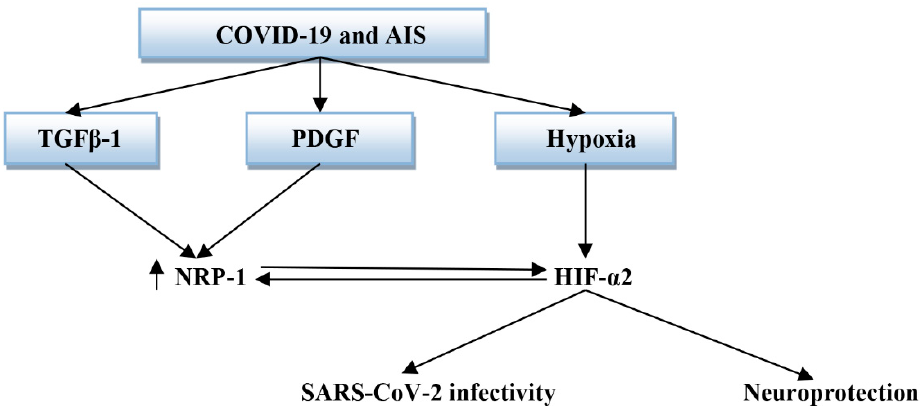
Figure 13. The potential role of the hypoxia-inducing factor (HIF), platelet-derived growth factor (PDGF), and transforming growth factor beta (TGF- β ) in COVID-19 and acute ischemic stroke (AIS): PDGF and TGF- β activate the expression of neuropilin-1 (NRP-1), while hypoxia induces the expression of HIF, which has neuroprotective effect and reduces SARS-CoV-2 infectivity. The net effect of NRP-1 in COVID-19 with AIS is through the induction of anti-inflammatory and antioxidant effects which reduce the severity of both COVID-19 with AIS [Figure 14].